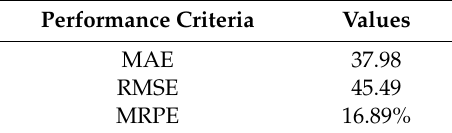
Table 4. Summary of model performance of estimated annual peak flows for the Imo River outlet between 1985 and